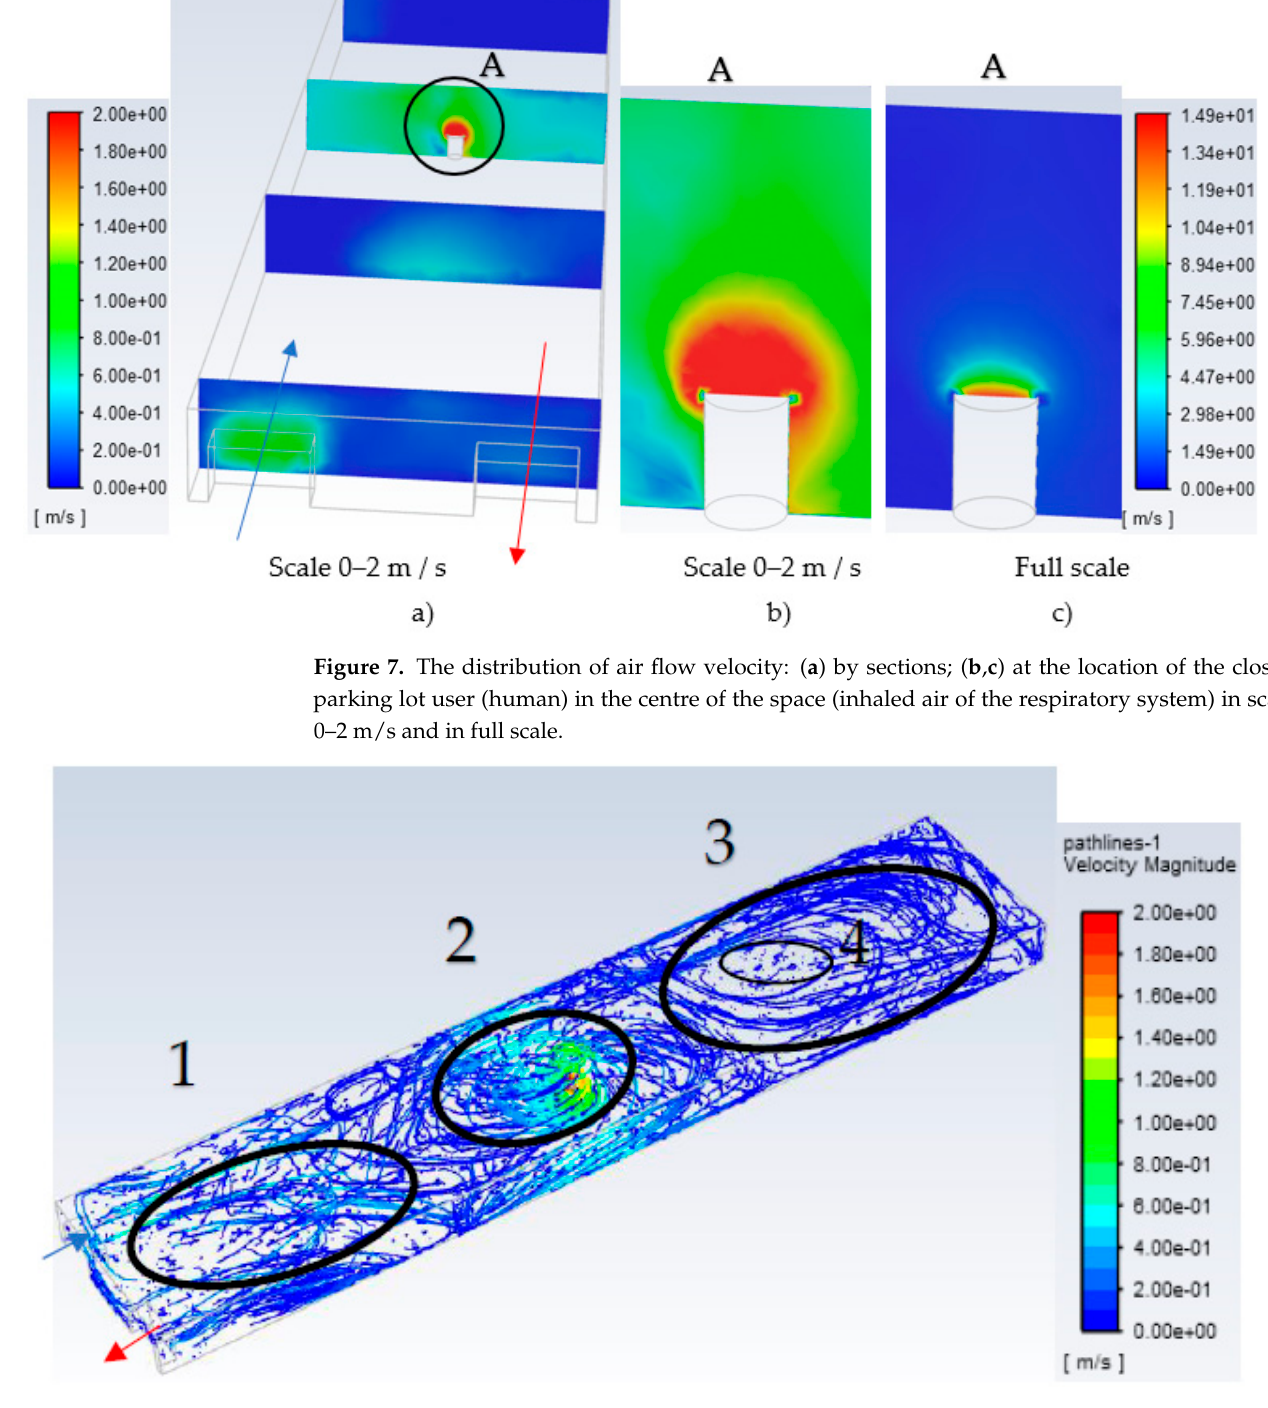
Figure 8. The distribution of air flows from inflow to potential human airways and outflow, scaled to 0–2 m/s.